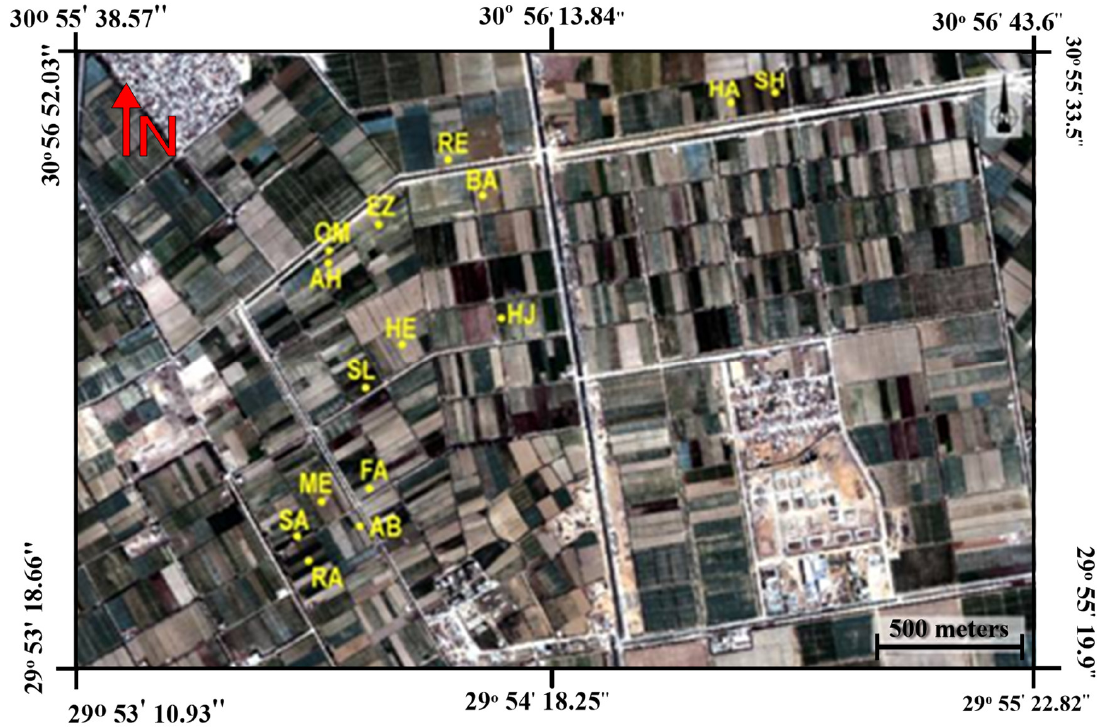
Figure 1. QuickBird satellite image showing different fields within the study area south-west Alexandria, Egypt. SH, HA, RE, BA, EZ, OM, AH, HJ, HE, SL, FA, ME, SA, FA and RA are the codes of 15 fields. RE, BA, EZ, OM, AH, HJ, HE, SL, FA, ME, SA, FA and RA are the codes of 15 Table 1. Agro-climatological data for the study area recorded at Borg Alarab Station (latitude of 31.2° and longitude of 29.916°). This data is just from the period of our experimentation.